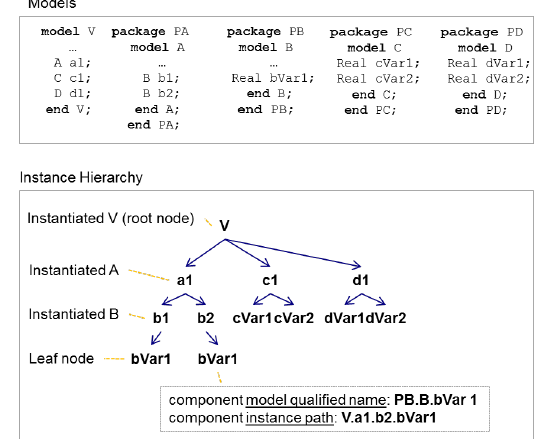
Figure 4: The information that needs to be captured in abstract